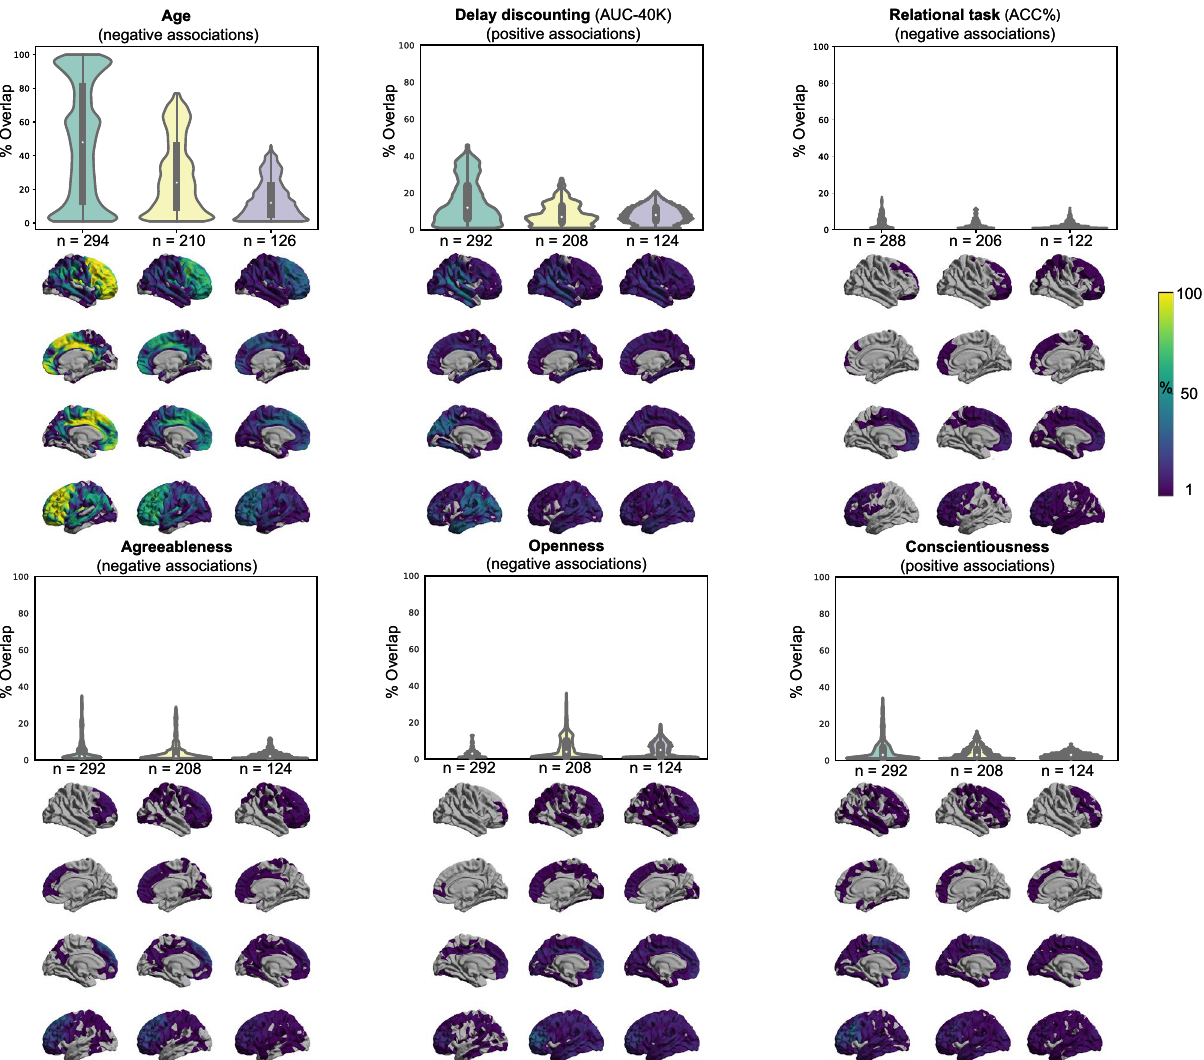
Figure 1. Replicability of exploratory results. Frequency of spatial overlap (density plots and aggregate maps) of significant findings from exploratory analysis over 100 random subsamples, calculated for three different sample sizes (x-axis). Here in addition to age, which is used as a benchmark, the top five behavioral scores with the highest frequency of overlapping findings are depicted. Brighter colors on spatial maps denote higher number of samples with a significant association at the respective vertex. AUC area under the curve, ACC